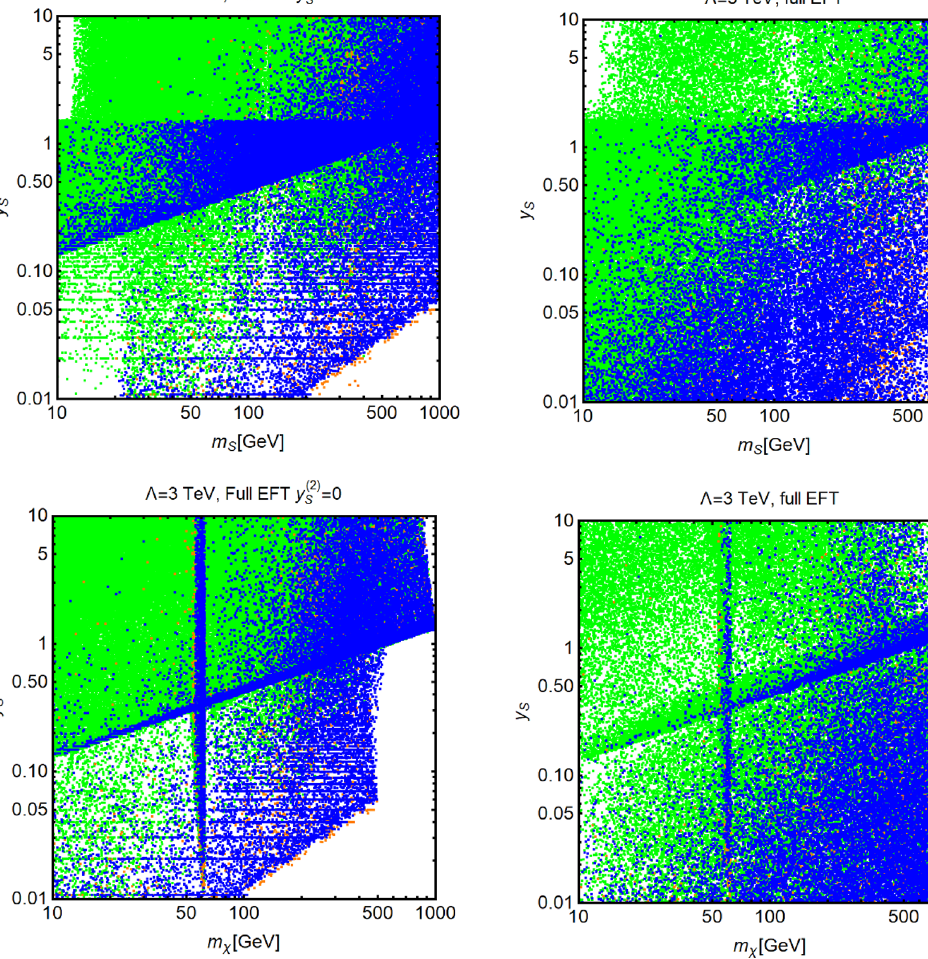
Figure 8 . Results of the parameter scan for the scalar e DMeft setup in the m S (cid:0) y S and m (cid:31) (cid:0) y S planes, following the same color code as in (cid:12)gure 7. While the right panels correspond to the full e DMeft , in the left panels we have set y (2) = S